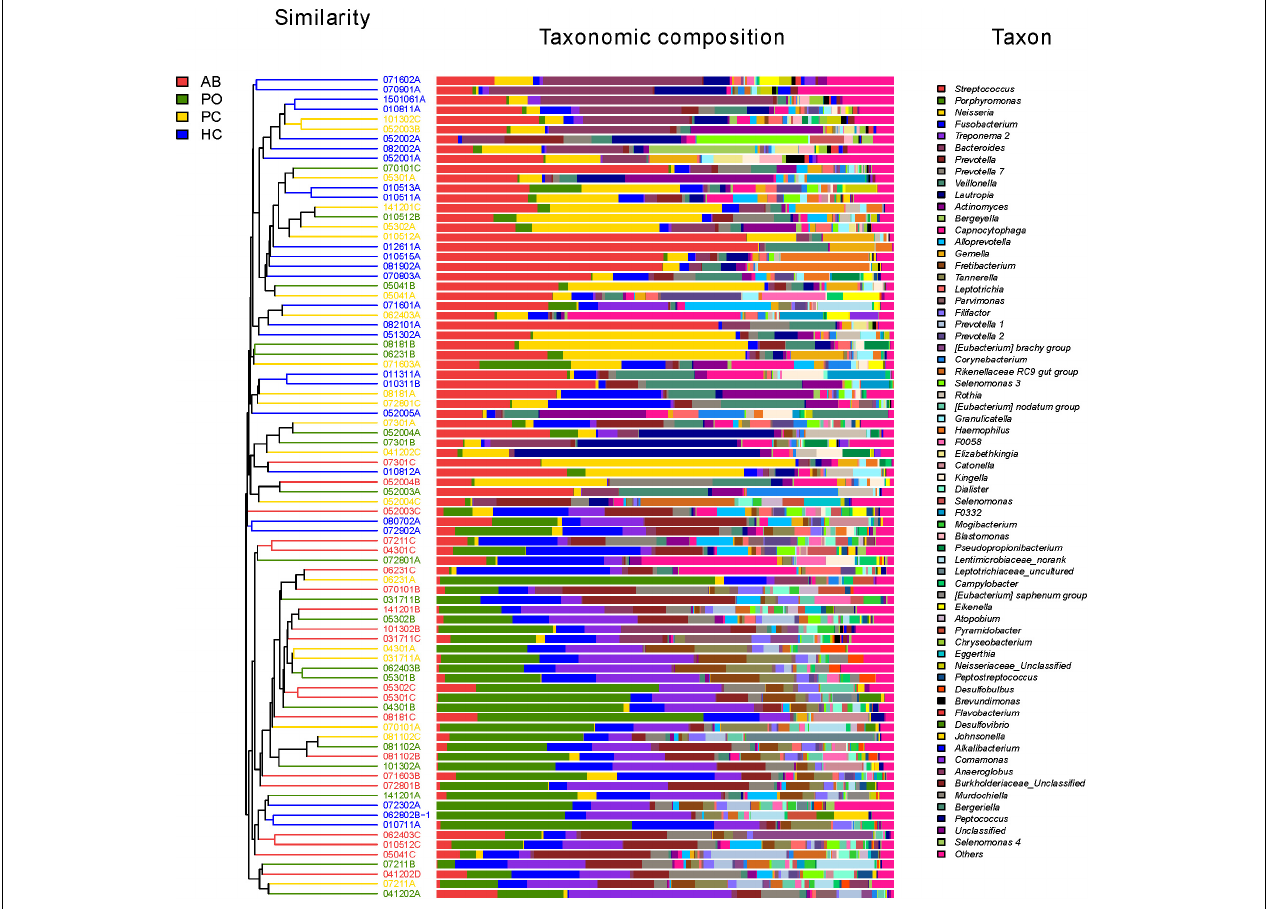
FIGURE 2 | Microbial community bar plot at the genus level with cluster tree. Each line shows the results of the bacterial community of one sample. Different bacterial taxonomies at the genus level (cutoff was set as 1%; some below 1% were shown as “others”) are shown in different colors on the right. The hierarchical cluster diagrams in all samples based on the community composition (based on the algorithm of Bray–Curtis) is shown on the left. Red color indicates that the specimen is in the AB group. Green color indicates that the specimen is in the pocket (PO) group. Yellow color indicates that the specimen is in the healthy control (HC). Blue color indicates that the specimen is in the patient control